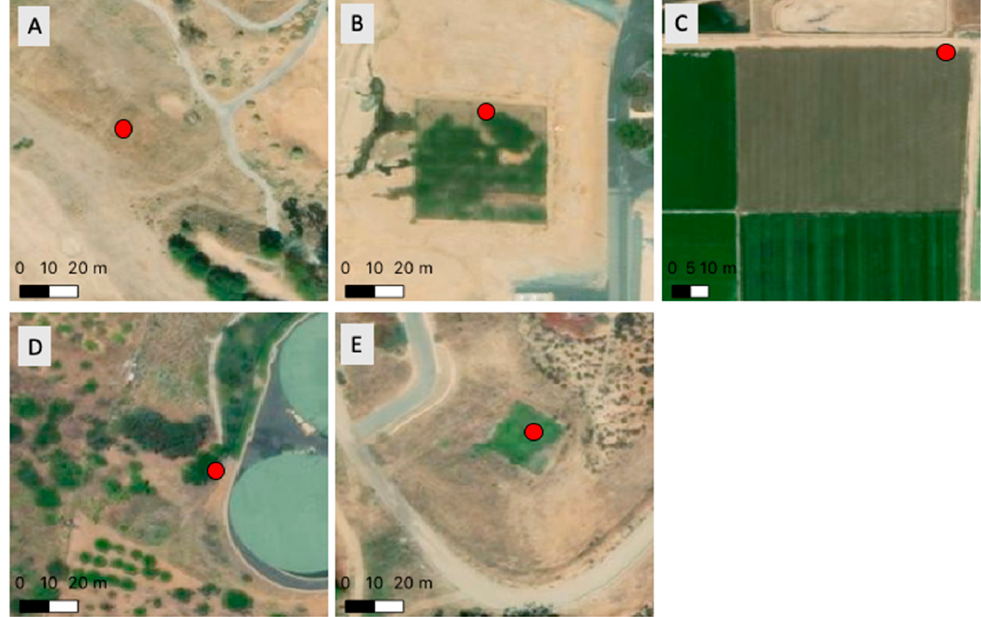
Figure 2. CIMIS stations in the Eastern Municipal Water District (EMWD) purview, located in heterogeneous environments. ( A ) Station 239/Hemet; ( B ) Station 240/Perris–Menifee; ( C ) Station 179/Winchester; ( D ) Station 62/Temecula; ( E ) Station 237/Temecula East III.